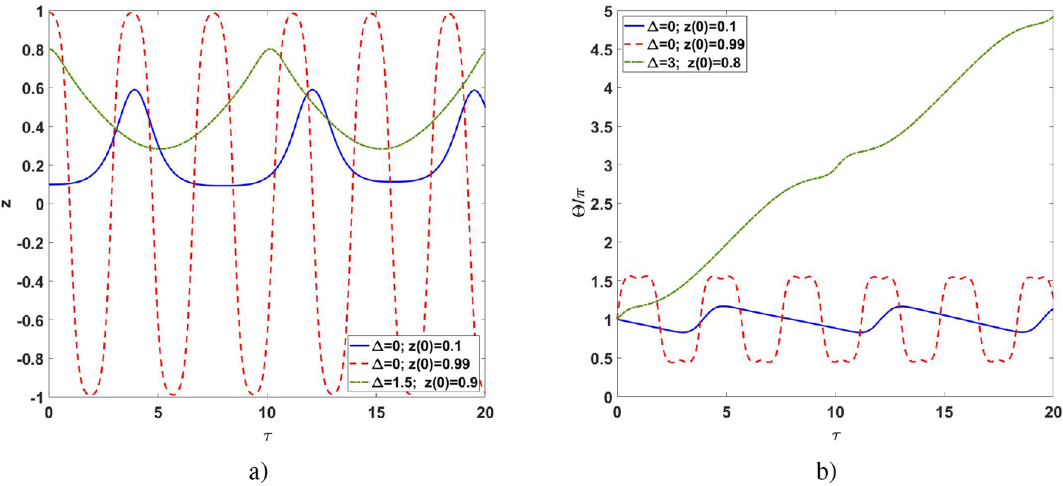
Figure 4. ( a ) The population imbalance z (τ) and ( b ) effective phase difference �(τ) versus reduced time τ for �( 0 ) π . =